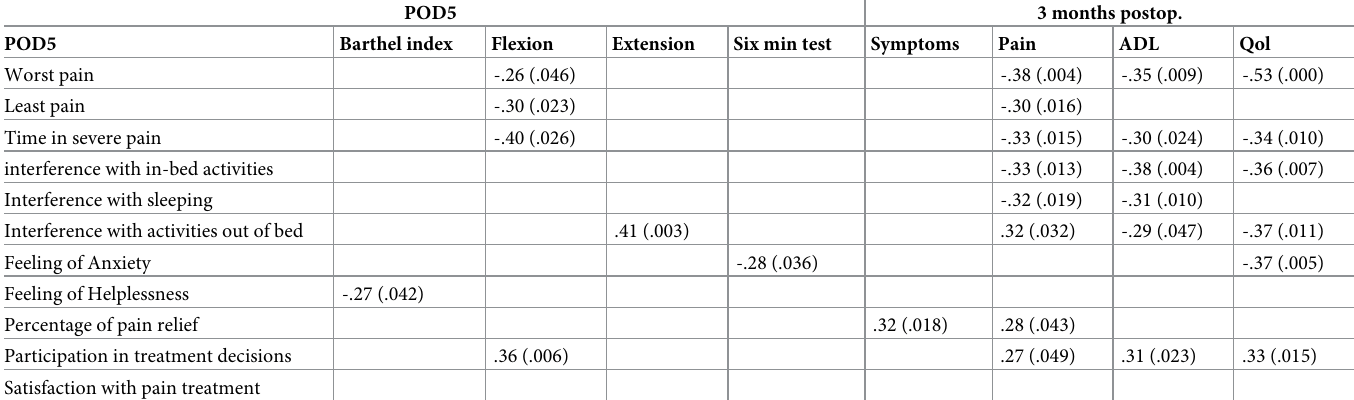
Table 7. Pearson correlation coefficients r between pain, functional interference and perception of care on POD5 and functional outcomes at POD5 and 3 months after surgery ( � p < 0.05).